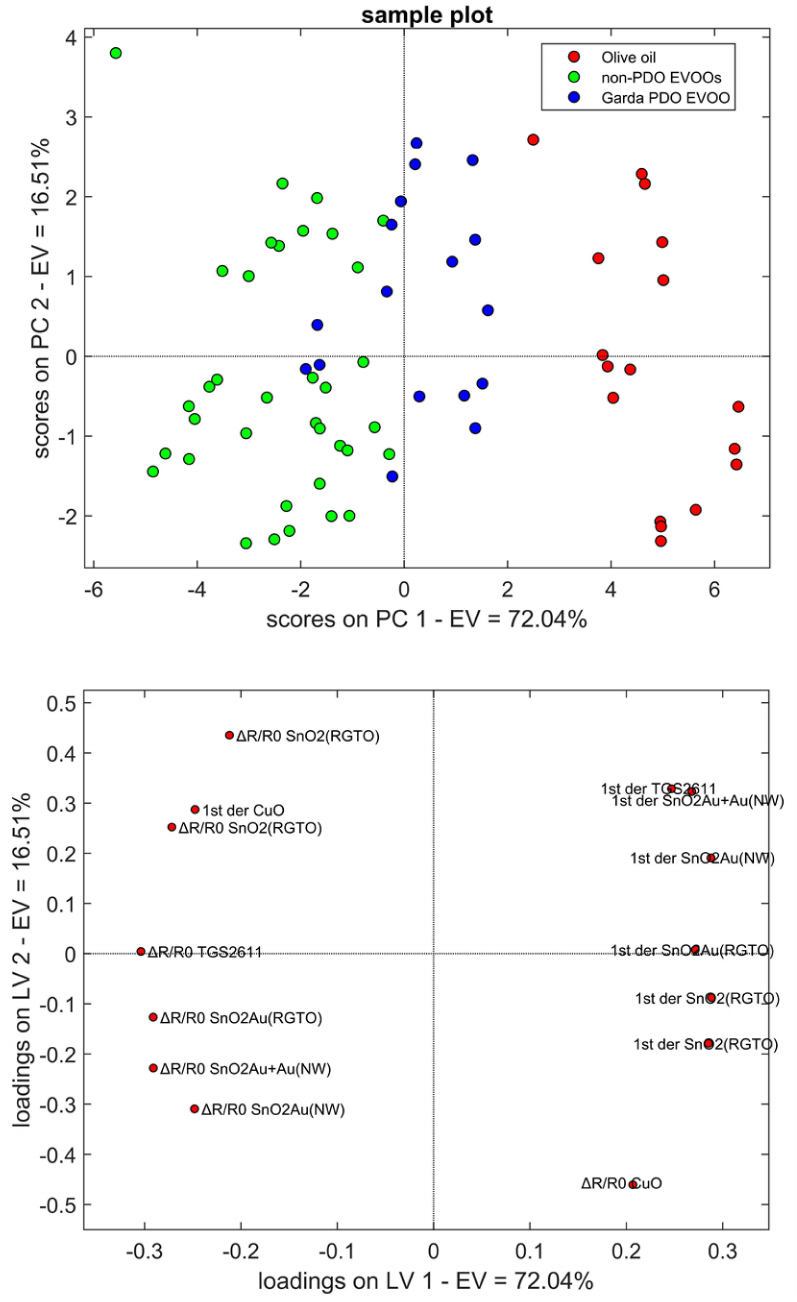
Figure 3. PCA score plot (top) and loading plot (bottom) of phase 1. PC1 variance = 72.04%, PC2 variance =